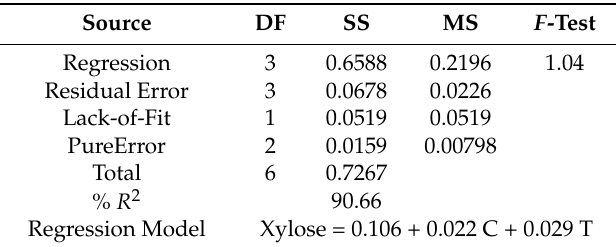
Table 2. Analysis of variance (ANOVA).